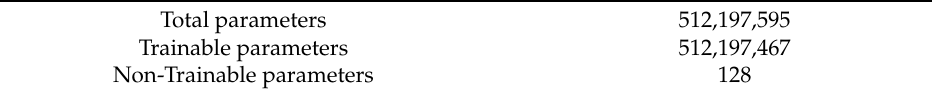
Table 2. The values of the parameters of the proposed